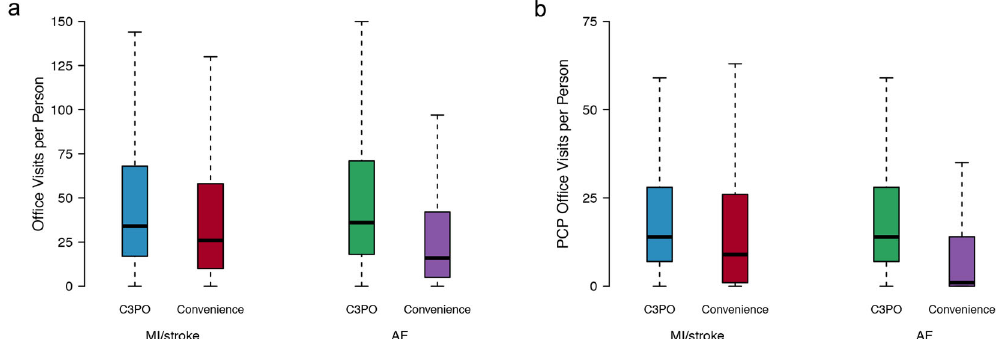
Fig. 2 Distribution of of fi ce visits in C3PO versus Convenience Samples. Depicted are boxplots demonstrating the distribution of of fi ce visits ( a ) and primary care physician (PCP) of fi ce visits ( b ) in the C3PO analysis samples (AF [blue] and MI/stroke [green]) versus the respective Convenience Samples (AF [red] and MI/stroke [purple]). In each boxplot, the black bar denotes the median number of of fi ce visits per individual, the box represents the interquartile range, and the whiskers represent points beyond the interquartile range. Points greater than quartile 3 plus 1.5 times the interquartile range and points smaller than quartile 1 minus 1.5 times the interquartile range are not depicted.